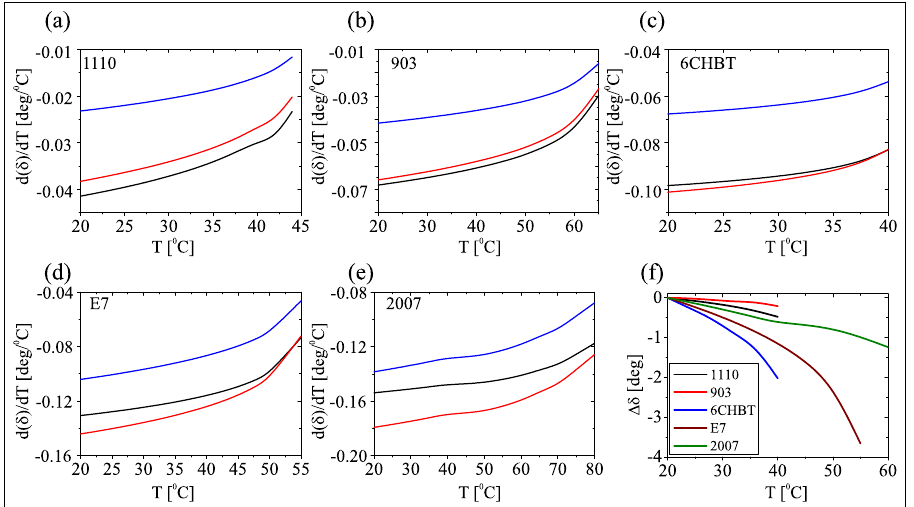
Figure 2. ( a – e ) Walk-off sensitivity to temperature for various θ 0 : black line θ 0 = 75 ◦ , red line θ 0 = 60 ◦ , blue line θ 0 = 45 ◦ for the NLC mixtures as labelled and ( f ) walk-off variation versus temperature with respect to its reference value, in the five NLC mixtures: 1110 (black), 903 (red), 6CHBT (blue), E7 (brown), 2007